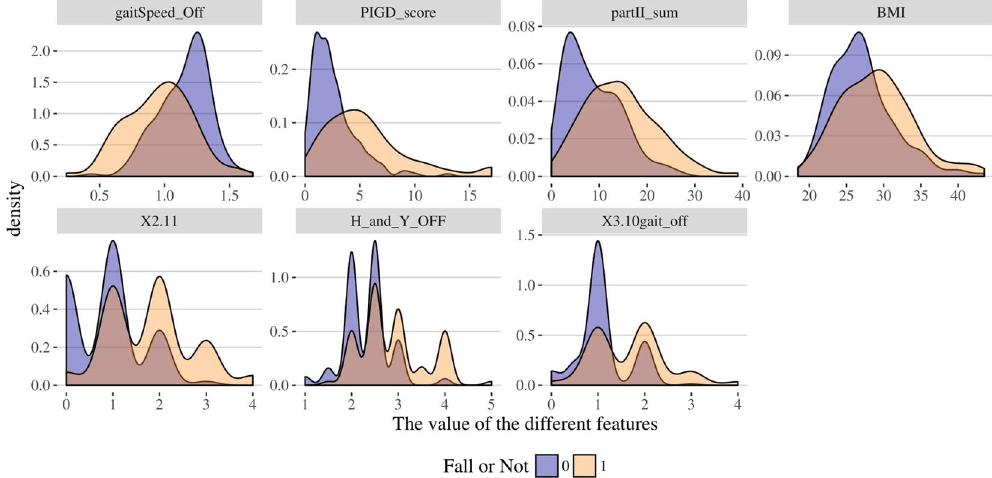
Figure 13. Density plots showing 7 selected clinical features with significantly different distributions between falls and no-fall groups.